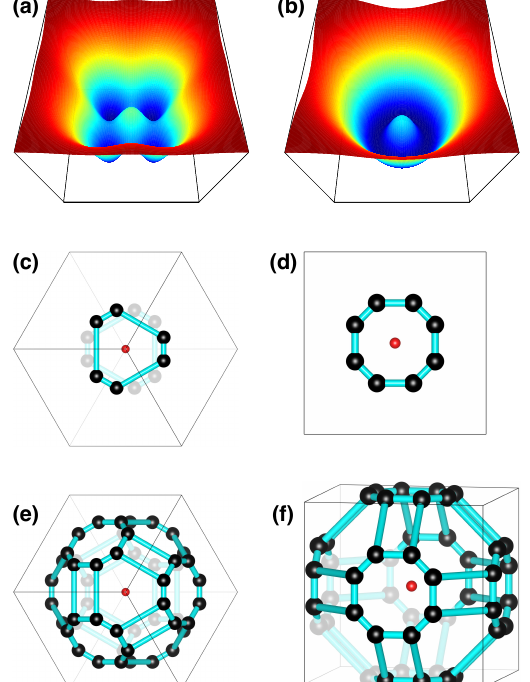
Figure 3. (color online) ( a , b ) Corrugated sombrero potentials with 4 ( a ) and 8 ( b ) equidistant LPEMs, given by Gaussians. ( c – f ) Networks of symmetry-equivalent displacements (black spheres) relative to x = 0 (red dot). Two-dimensional basin with ( c ) hexagonal 3-fold rotational symmetry (shaded is its inversion) and ( d ) square 4-fold rotational symmetry. ( e ) The [111] projection, with shading below [111] plane through 3 corners of the cube, and ( f ) a view of the central part of a basin with 48 dimples, forming a 3D cubic lattice. LPEMs (black spheres) are displacements from a local maximum at the center (red dot). MEPs between pairs of LPEMs are represented by lines (light blue) that are not necessarily